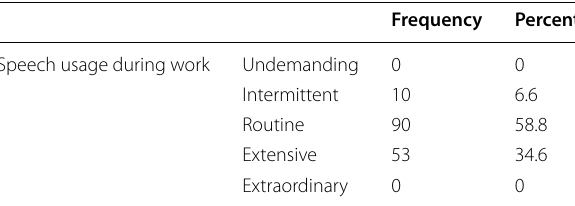
Table 3 The levels of speech usage during work among